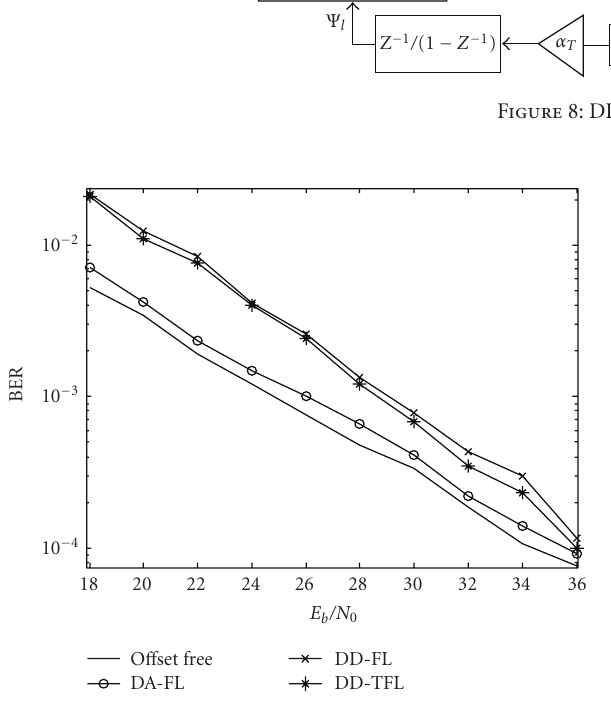
Figure 9: BER values for 802.11n.